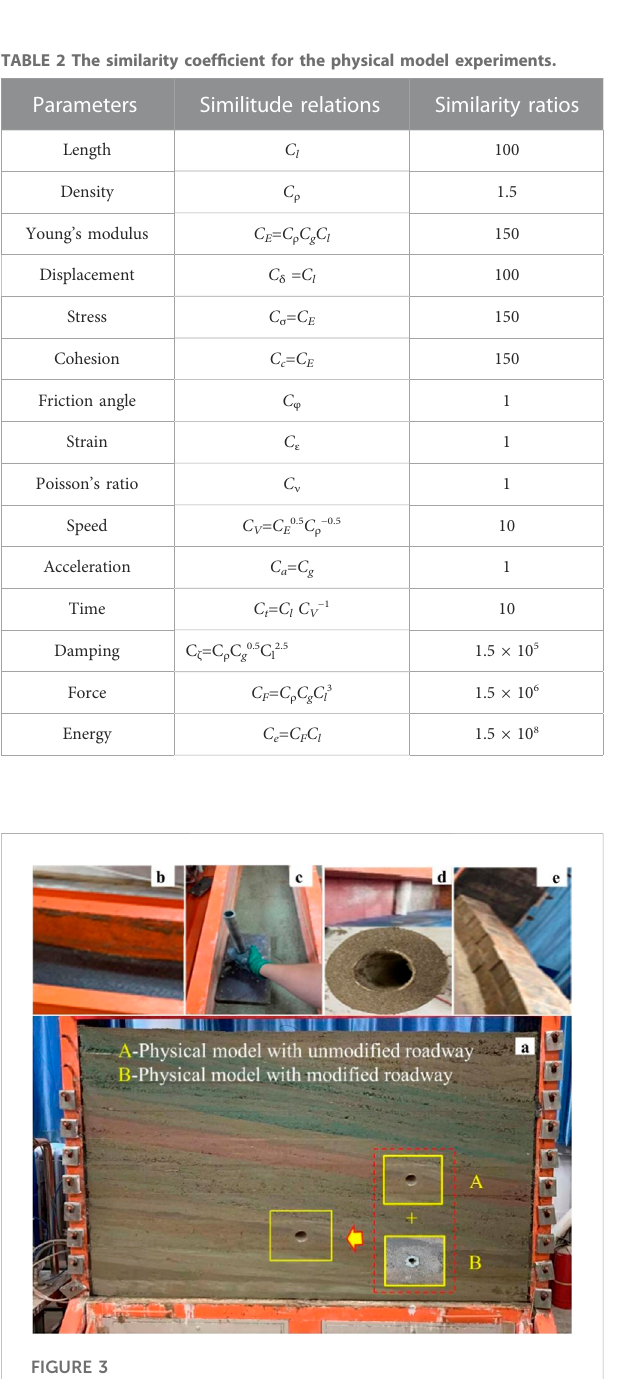
FIGURE 3 Thephysical modelswithan unmodi fi edroadwayand amodi fi ed roadway. (A) integral physical model, (B) placing a layer of black foam, (C) compacting the similar materials, (D) using a concentric con fi guration to model the cracked zone and reinforced zone, (E) appling the iro blocks on model